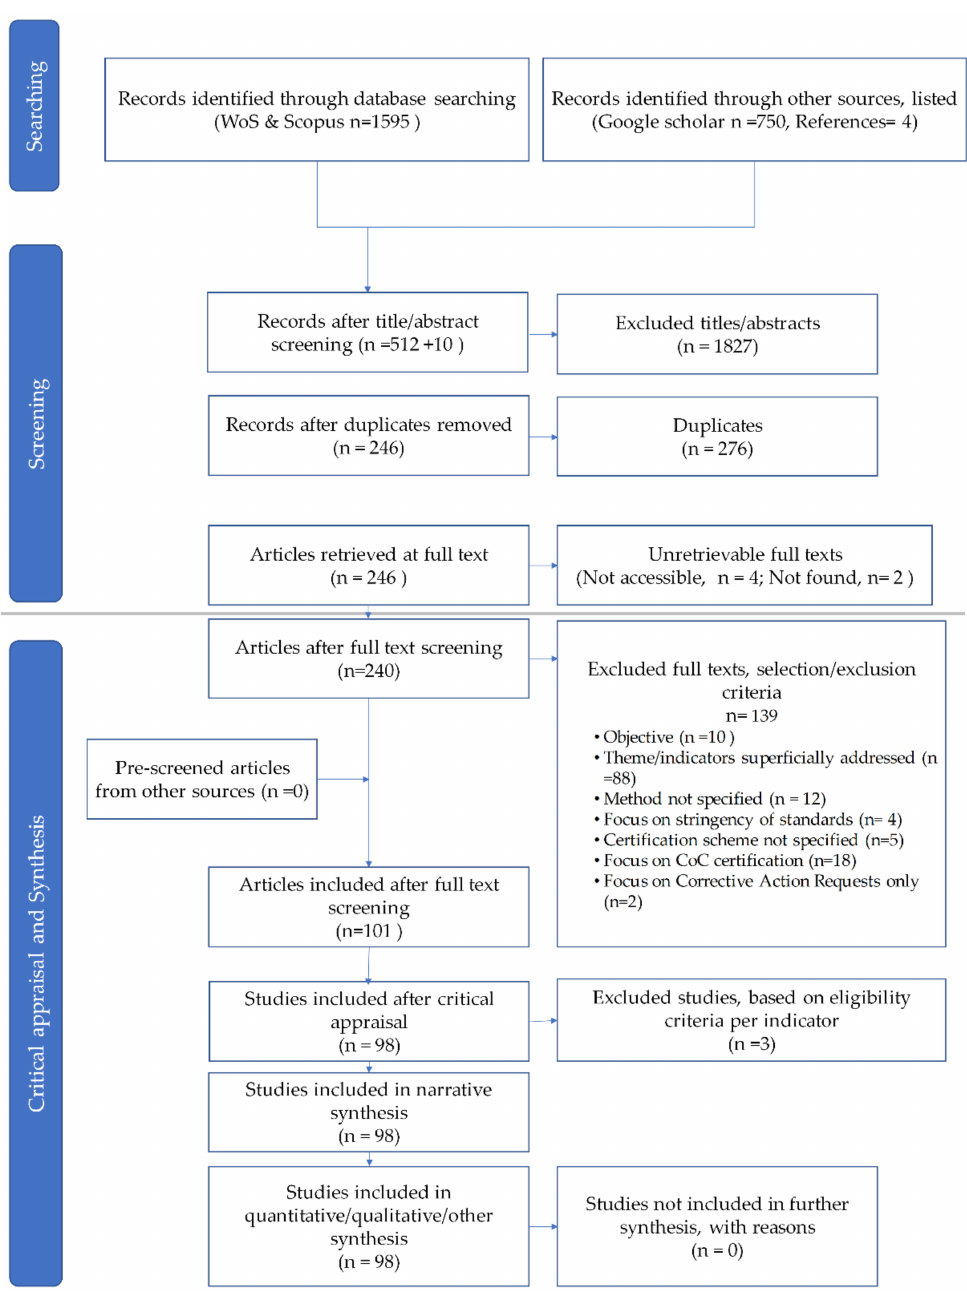
Figure A1. ROSES flow diagram for the systematic review of empirical